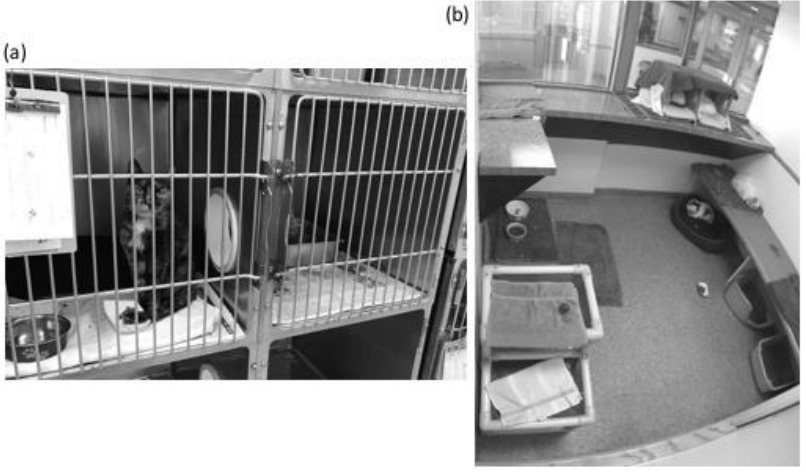
Figure 1. Example housing units. ( a ) A single cat cage with two compartments connected by a porthole; ( b ) A group housing room containing four cats in 5.41 m 2 .